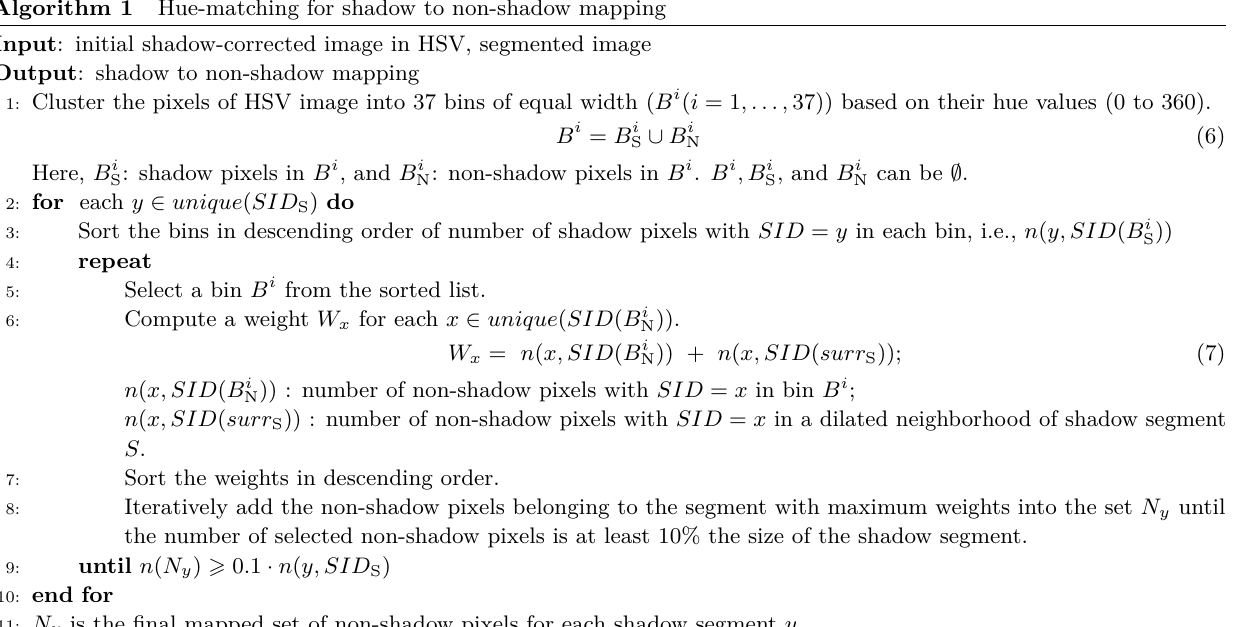
Algorithm 1 Hue-matching for shadow to non-shadow